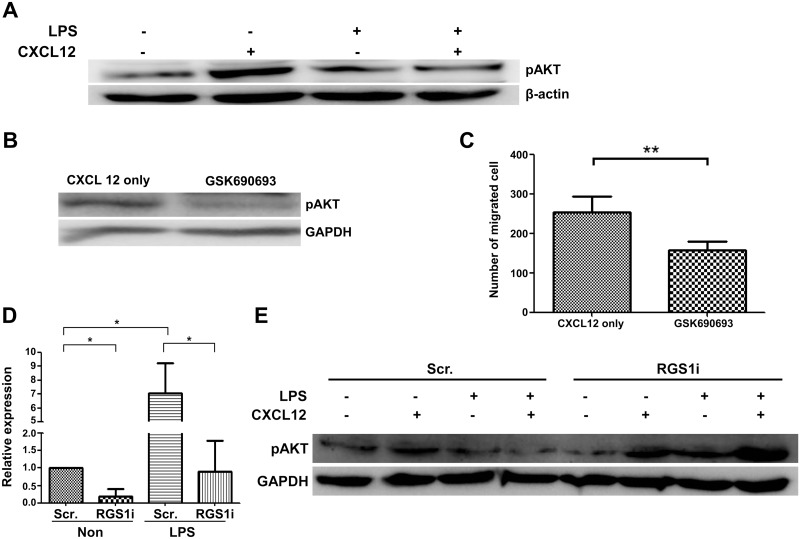
CXCL12-induced migration via AKT is reduced by LPS treatment.A) RPMI 8226 cells were stimulated with 100 ng/mL CXCL12 for 5 minutes in the presence or absence of 10 ng/mL LPS. To determine the decrease in AKT phosphorylation induced by CXCL12 in LPS-treated cells, cells were assessed using western blot analysis for phosphorylated ERK1/2, phosphorylated AKT, and β-actin. B–C) AKT activation is required for the CXCL12-mediated migration of RPMI 8226 cells. Cells were treated with an AKT-specific inhibitor (GSK690693) for 2 hours, and the treated cells were assessed by western blot and CXCL12-mediated transwell migration assays. To knockdown RGS1 in RPMI 8226 cells, the cells were transfected with RGS1i using a Neon electroporator. Three days after electroporation, the cells were stimulated with LPS for 18 hours. D) Reduction in RGS1 expression in RGS1i-transfected RPMI 8226 cells. E) Western blots of ERK and AKT phosphorylation in Scr- and RGS1i-transfected cells. The decrease in AKT phosphorylation induced by CXCL12 in LPS treated-cells was reduced in RGS1i-transfected cells (*p < 0.05; **p < 0.005; ***p < 0.0005).